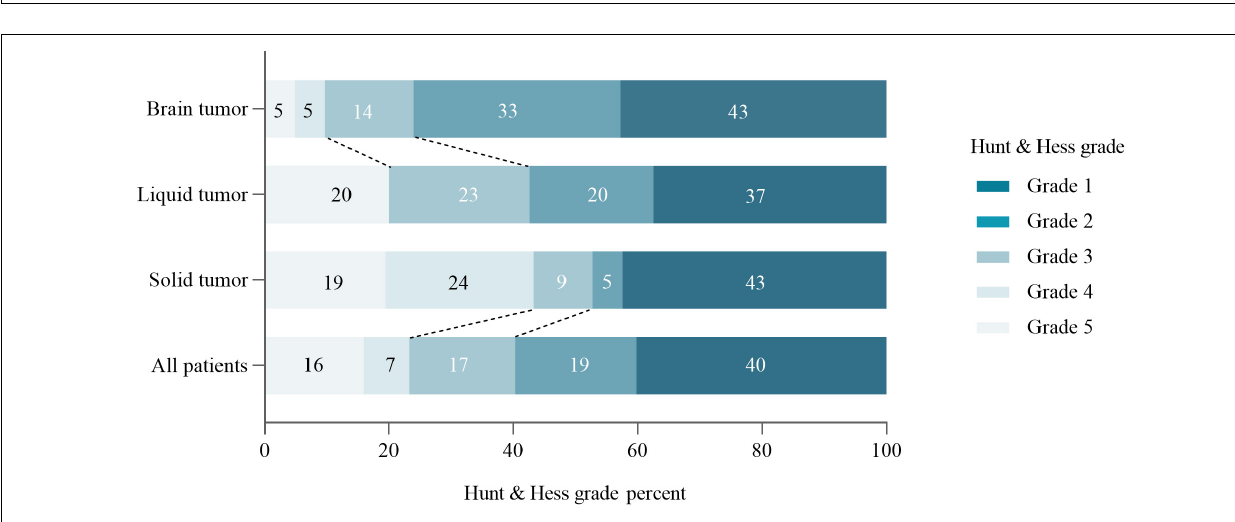
FIGURE 3 | Imaging features. (A–C) Were from a 28-year- female with astrocytic glioma experienced SAH due to ITH in the first 11 days after the diagnosis of astrocytic glioma. It shows a tumor in the brain (white triangle) and subarachnoid hemorrhage (thin white arrow) in (A) , intratumoral bleeding in (B) (thick white arrow), normal cerebral arteries in (C) . (D–F) Were from a middle-aged female patient with acute monocytic leukemia combined with coagulopathy suffered from SAH. (D,E) Showed massive subarachnoid hemorrhage with ventricle hematoma. (F) Shows normal cerebral arteries.